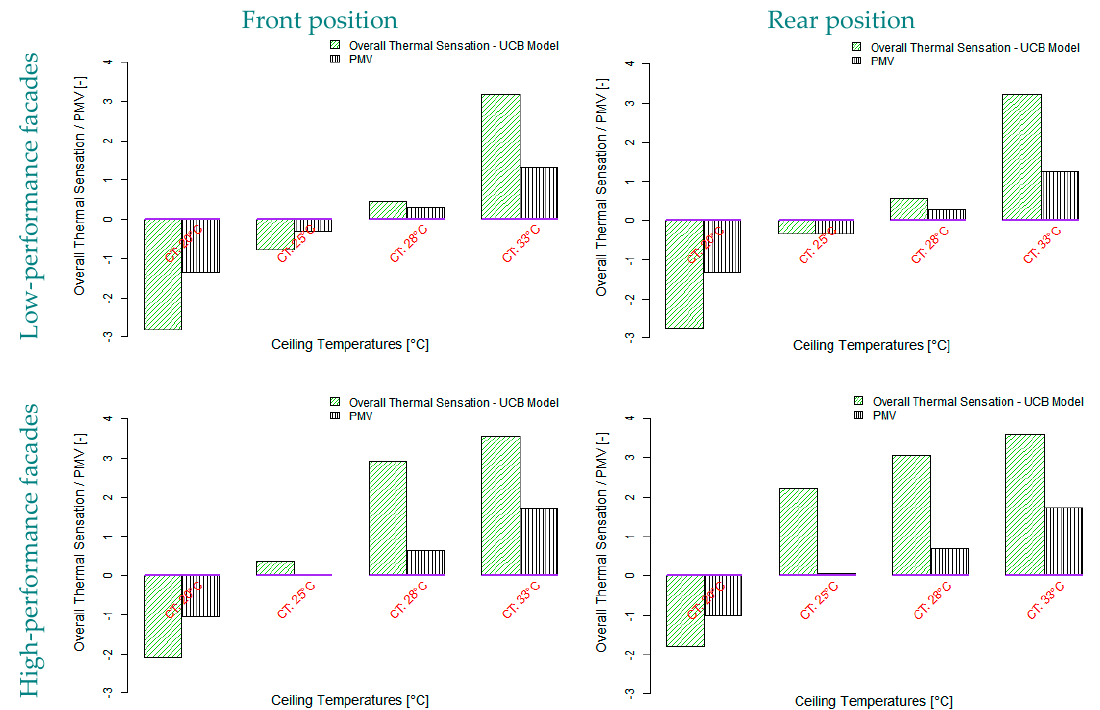
Figure A2. Comparisons between overall thermal sensation values calculated by UCB model-based 16 local thermal sensation values [10] and PMVs calculated using the six environmental and personal parameters [7] in the corner room with two facades.